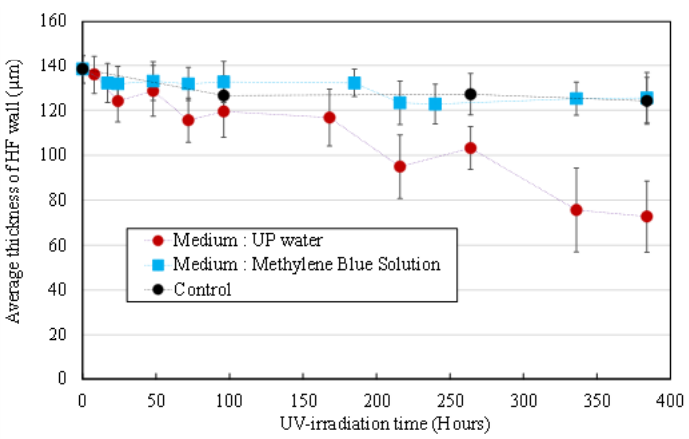
Figure 4. Average thickness of HFs ’ wall after UV irradiation at 1000 µW/cm² in an MB solution ( blue squares ), in UP water ( red dots ). Control is non-irradiated HFs in am MB solution ( black dots ).